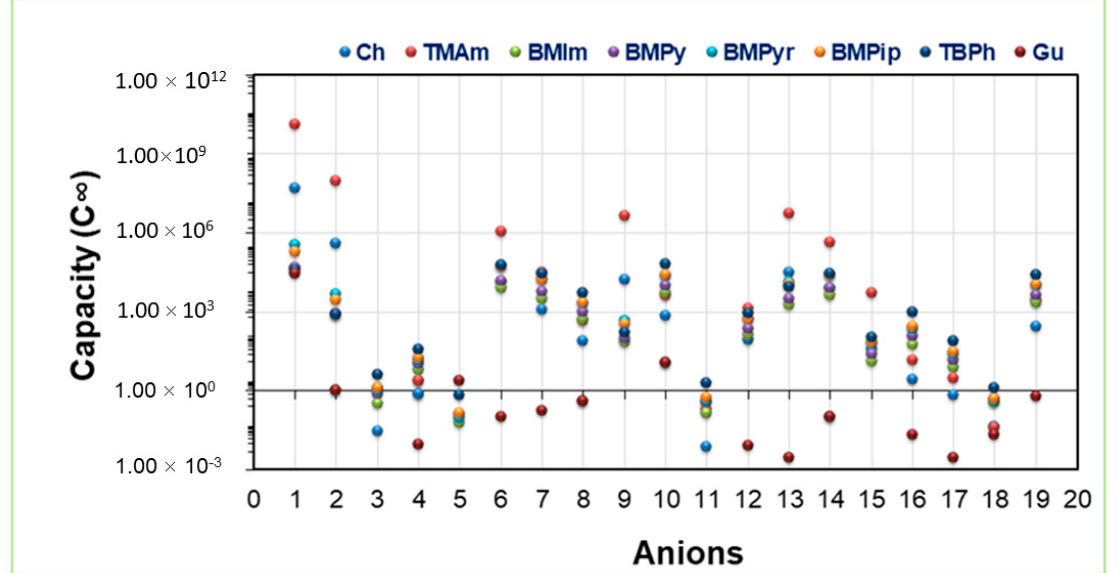
Figure 4. Capacity of the studied ILs for Ibf extraction